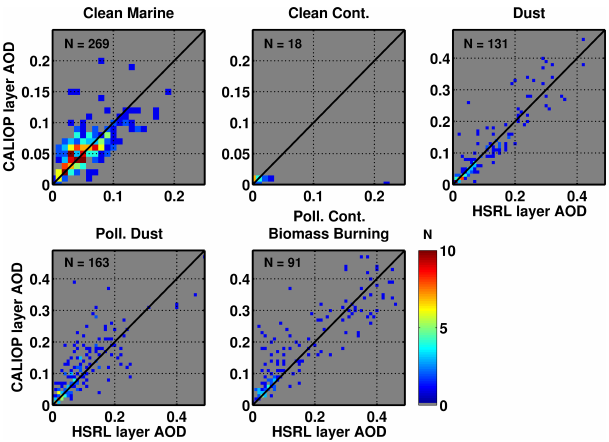
Figure 13. Combined daytime and nighttime scatterplots of CALIOP layer AOD and HSRL layer AOD for each aerosol type with the restriction that the CALIOP lidar ratio is within 30% of the HSRL lidar